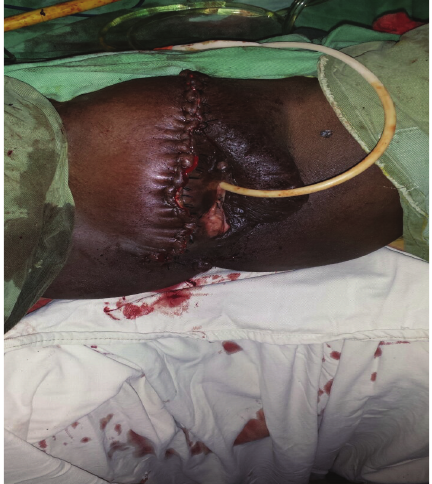
Figure 4: Giant condyloma excised from patient “B.” The right labia majora was excised with the specimen with minimal invasion noted. The left side of the vulva was